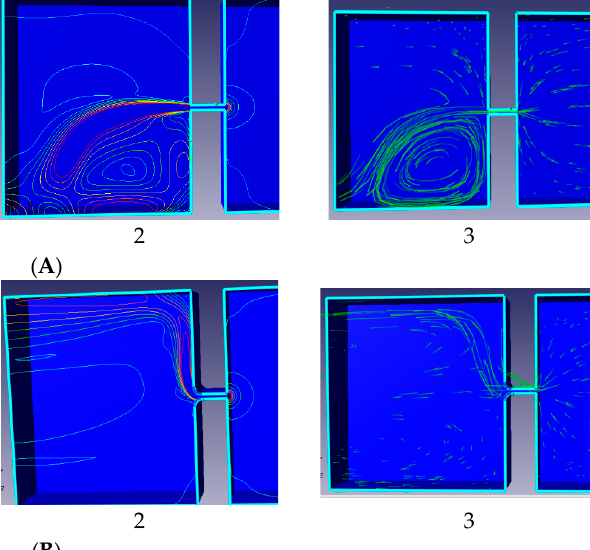
Table 1. Results of a numerical study (cid:4672)